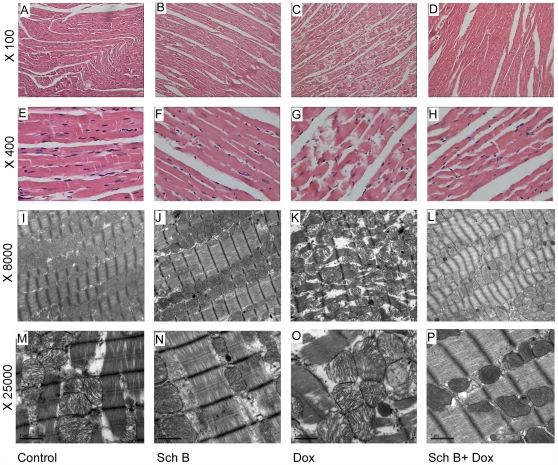
Sch B alleviates Dox-induced myocardial damage in left ventricles of rats.Rats were treated with Dox (2.5 mg/kg, i.p.) with or without pretreatment of Sch B, weekly over 5 weeks, followed by analysis of light or electron microscope 6 weeks after the last dose of Dox. Representative images of histology with hematoxylin-eosin staining (A–H) and ultrastructure (I–P) are shown.